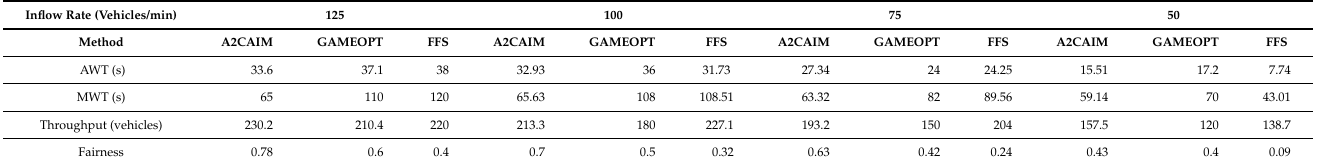
Table 7. Average performance results over ten simulations using four different inflow